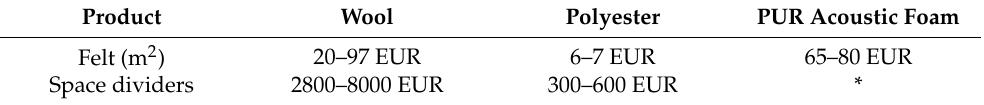
Table 4. Price comparison between wool and synthetic sound-absorbing